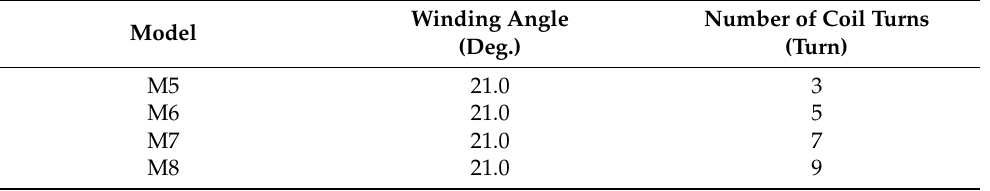
Table 3. Coil specification according to number of coil